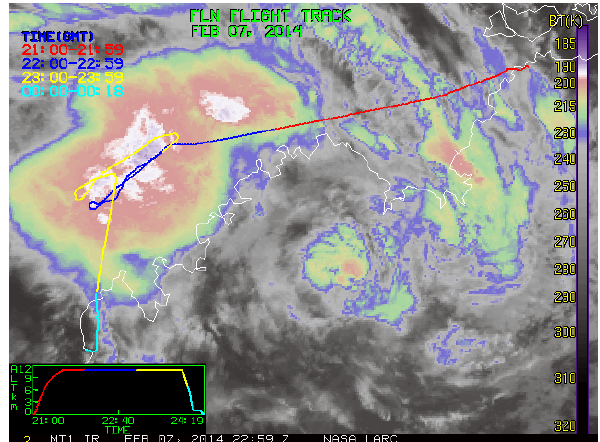
Figure 1. Flight track of the Falcon 20 on 7 February 2014, which departed from Darwin, Australia (red segment) and landed in Broome (cyan segment), overlaid upon a MTSAT-1R JAMI color- enhanced BTW image at 22:59UTC. The track is color coded by the time of observation specified in the